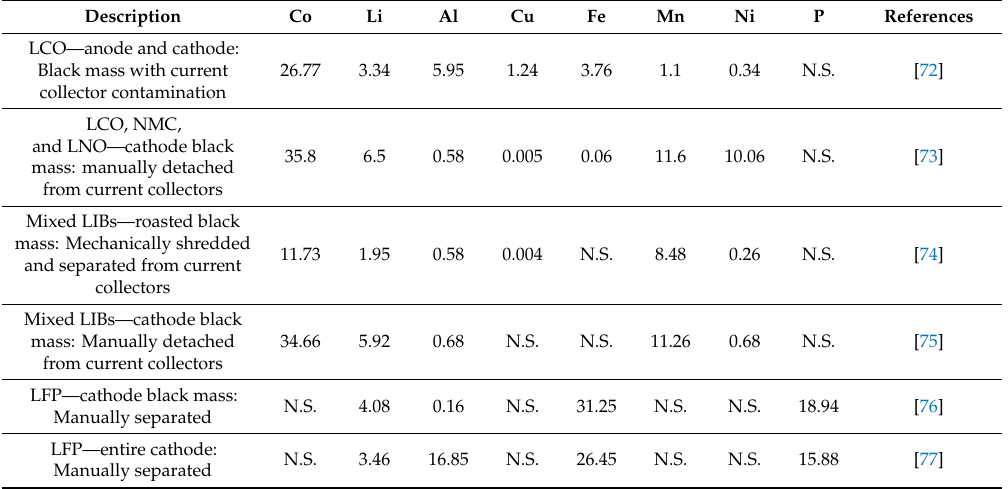
Table 5. Elemental composition of spent Li-ion battery (LIB) electrodes (wt.%) reported in the literature; here, LCO, NMC, LNO, and LFP are lithium-cobalt oxide, lithium-nickel-manganese-cobalt oxide, lithium-nickel oxide, and lithium-iron phosphate, respectively; and N.S. is not